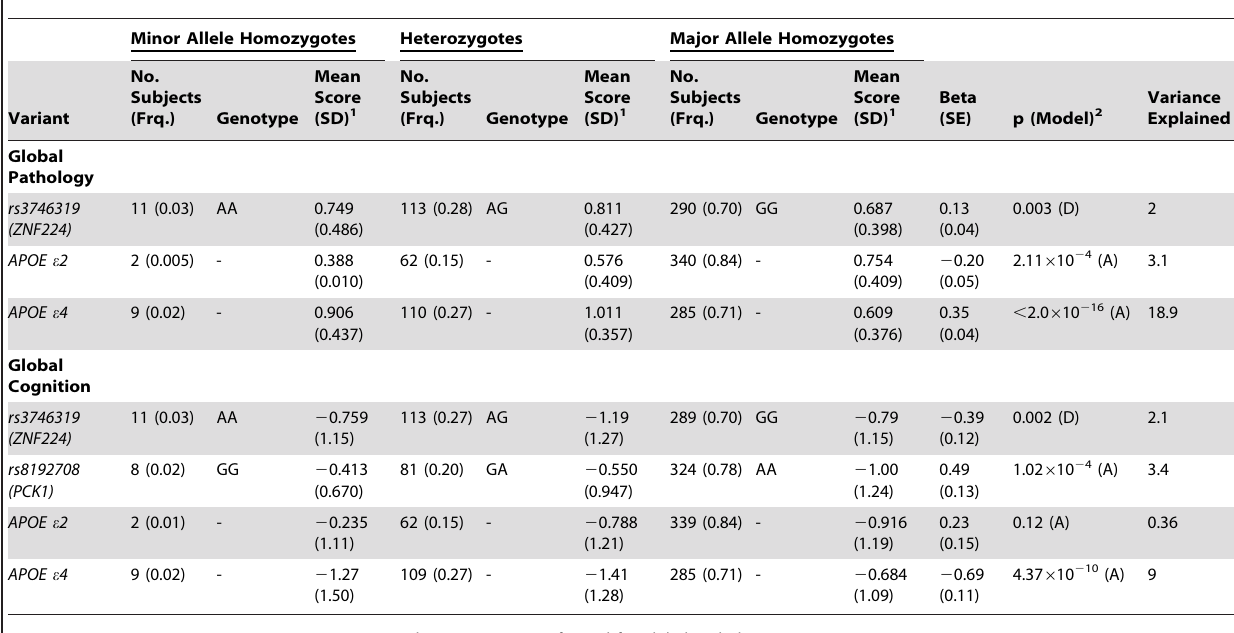
Table 6. Detailed genotype-phenotype data and statistical modeling.